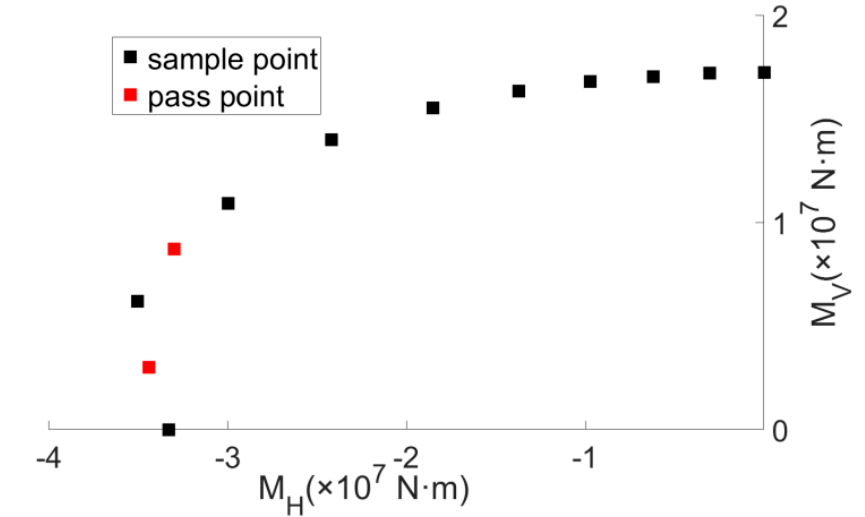
Figure 1. Distribution of the sample points.